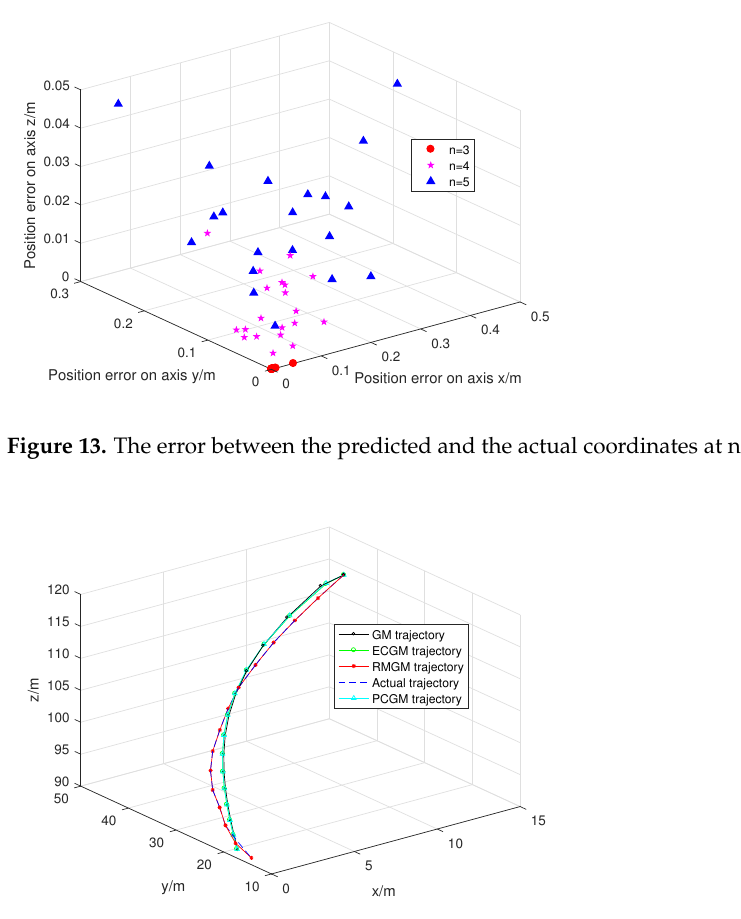
Figure 14. Predicted trajectories of the GM, ECGM, PCGM, and RMGM models.